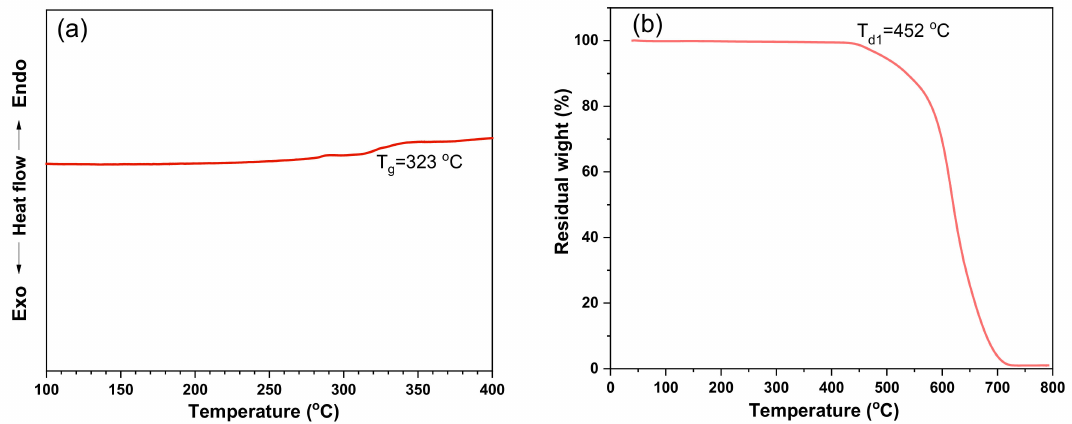
Figure 4. DSC curve ( a ) and TGA curve ( b ) of TPPI fiber